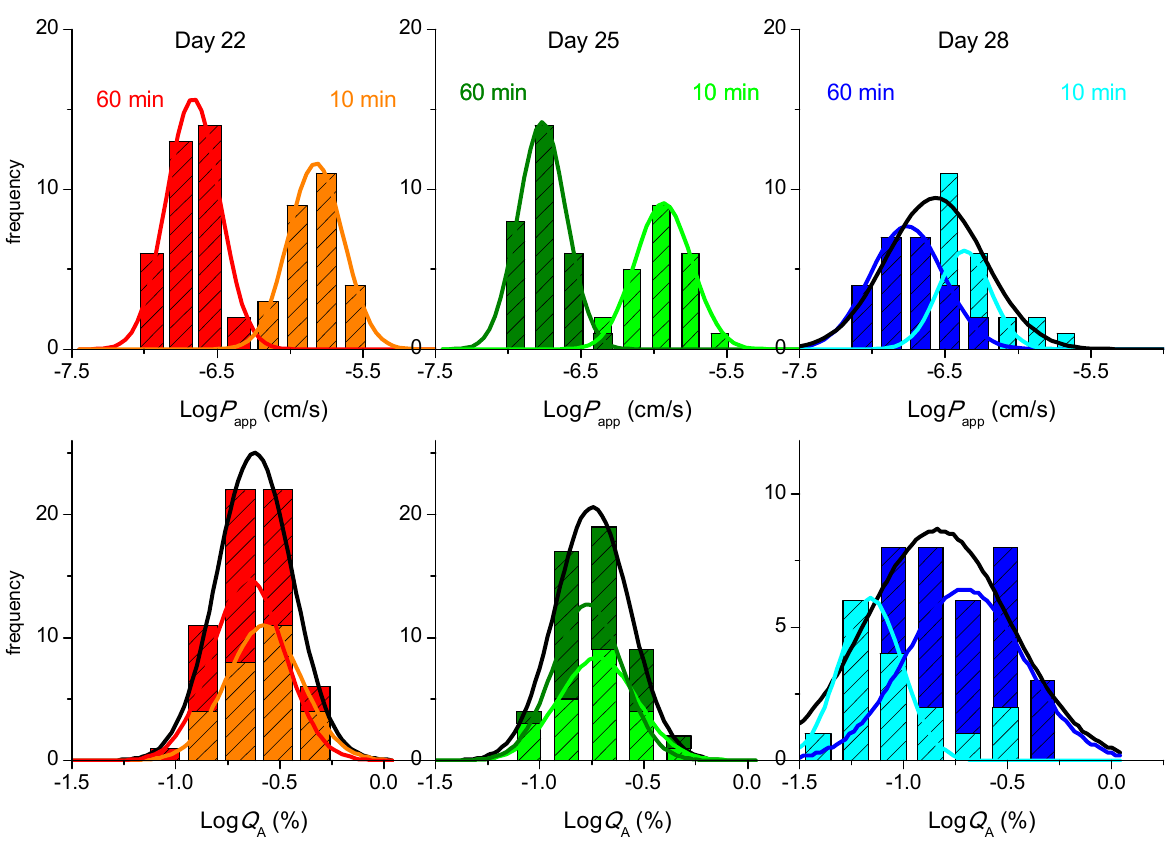
Figure 4. Effect of the sampling time interval on the paracellular permeability of LY through Caco-2 monolayers for cells at day 22, 25, or 28, post-seeding. The LY transport expressed as the Logarithm of the instantaneous permeability (Log P app ) is shown in the upper plots, while that expressed as the Logarithm of the amount of LY that permeates (Log Q A ) is shown in the lower plots, for a sampling interval of 10 min (light colors) or 60 min (dark colors). The lines are the best fit of a Normal distribution, with the parameters given in the Supplementary Material—Table S4, the black line corresponding to the cumulative data from both sampling time intervals.